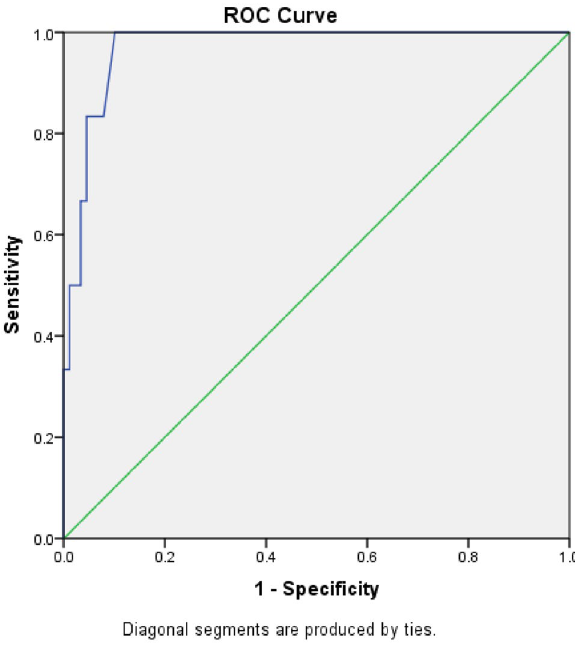
Figure 3. Receiver operator curve for Hs-cTn. X-axis is sensitivity or True positive. Y-axis is 1-specficity or True negative rate. Blue line is test performance with area under the curve of 97%. Green line is when test can’t differentiate true positive from true negative as chances are 50% for both.